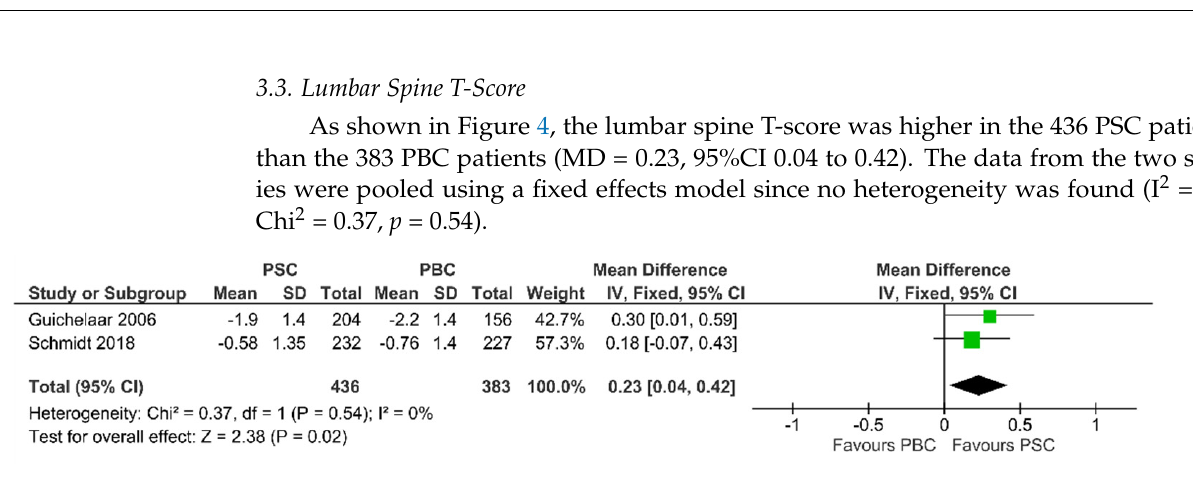
Figure 4. Forest plot assuming a fixed-effects model for T-score PSC vs. PBC [30,33].